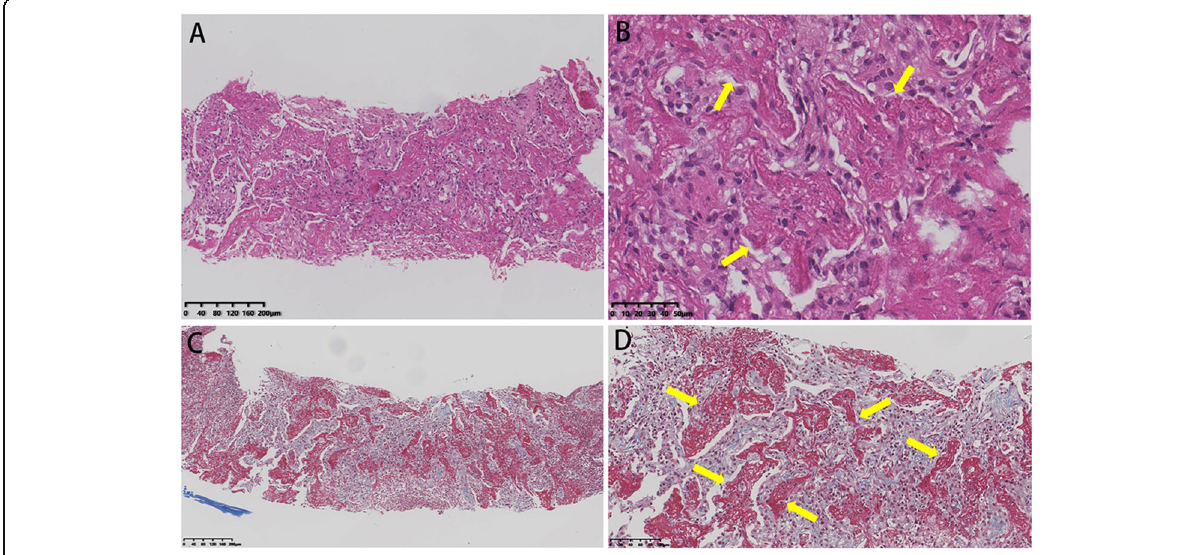
Fig. 4 Histologic findings of case 2 on lung biopsy. Hematoxylin and eosin stain ( A , ×100) ( B , ×200) showed there was interstitial fibrosis and abundant of fibrous exudate filled in the alveoli(arrows), which was highlighted by Masson ’ s trichrome stain ( C , ×100) ( D , ×200)